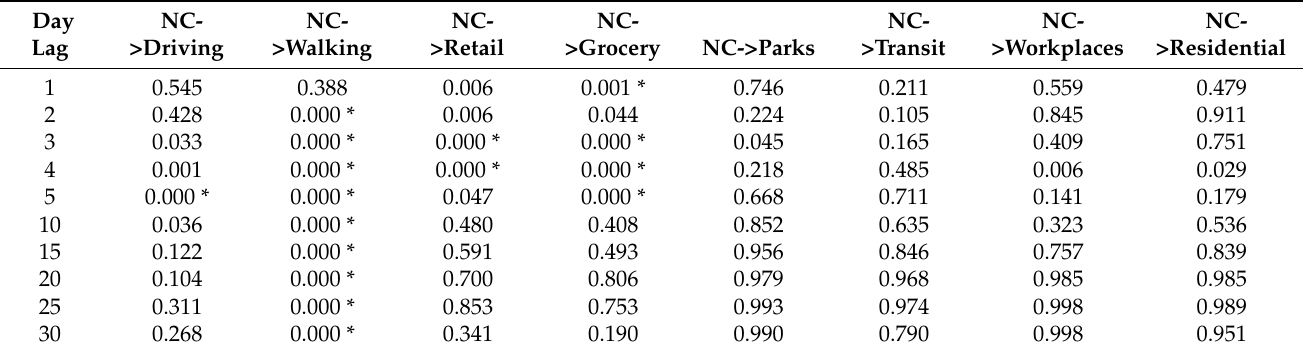
Table A17. New_cases (NC), Granger-cause mobility variables, and p -values in day lags in Portugal.